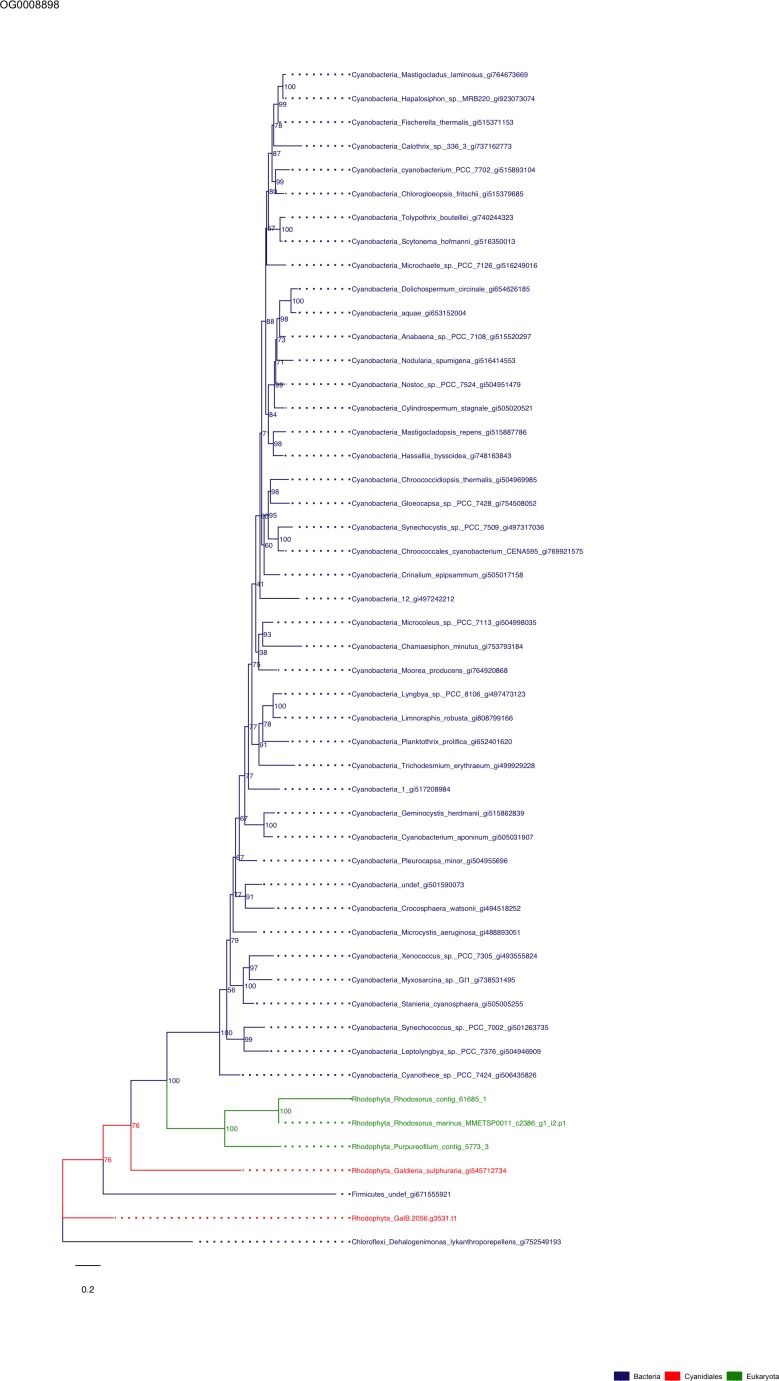
Sequence tree of orthogroup OG0008898.The tree is based on amino acid sequences. Archaea (yellow), Bacteria (blue), Cyanidiales (red), Eukaryotes including other red algae (green). Branches containing Cyanidiales sequences are highlited in red.